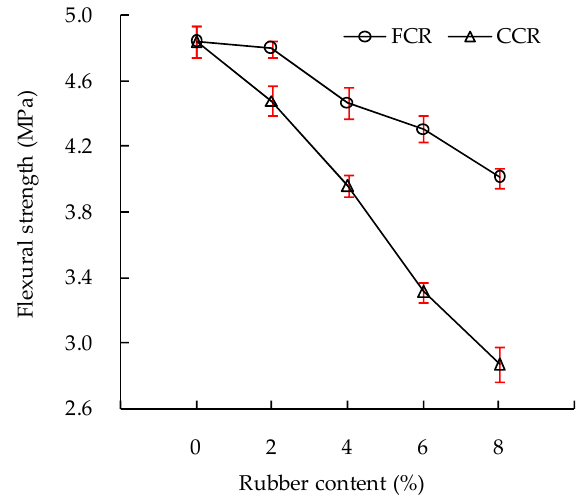
Figure 7. Flexural strength of RMPC versus rubber content.